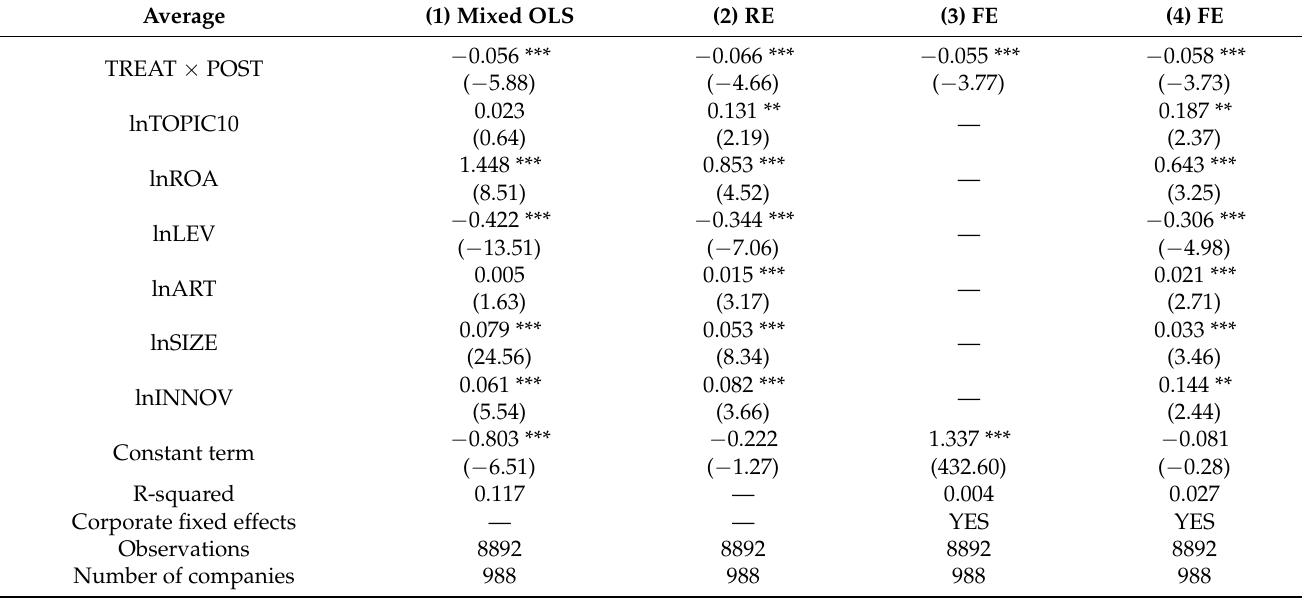
Table 4. Baseline regression